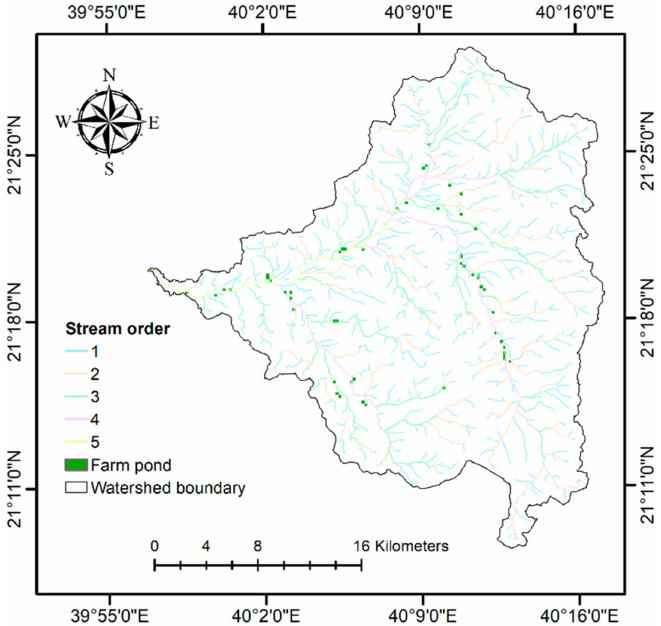
Figure 13. Zones suitable for the farm ponds within the watershed